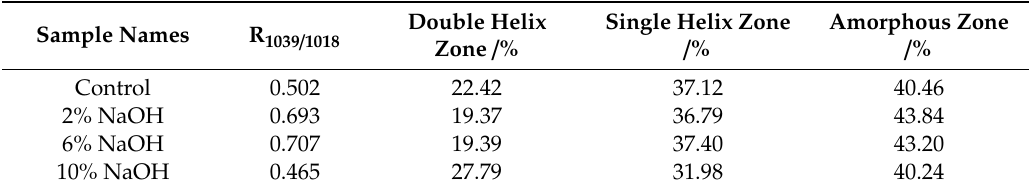
Table 2. R 1039 / 1018 values, single and double helix structures, and amorphous area peak area ratio of HAS films treated with di ff erent concentrations of NaOH.